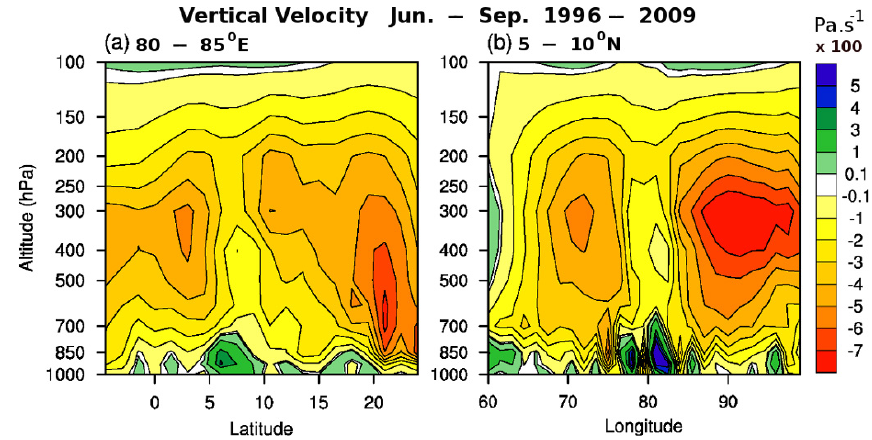
Fig. 5. (a) Long-term (1996–2009) seaonal mean latitude-altitude cross section of the pressure vertical velocity (Pas − 1 × 100) averaged along 80–85 ◦ E, obtained from ERA. (b) Same as (a) but for the longitude-altitude cross section averaged along 5–10 ◦ N. The vertical velocities are multiplied by 100 in the above figures for better